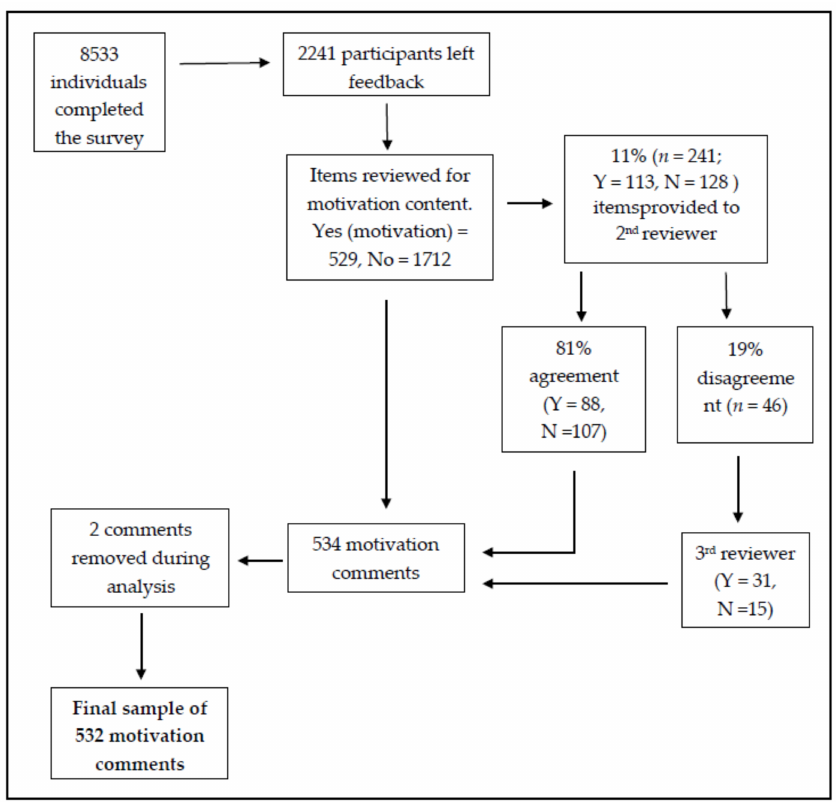
Figure 1. Study participant flow